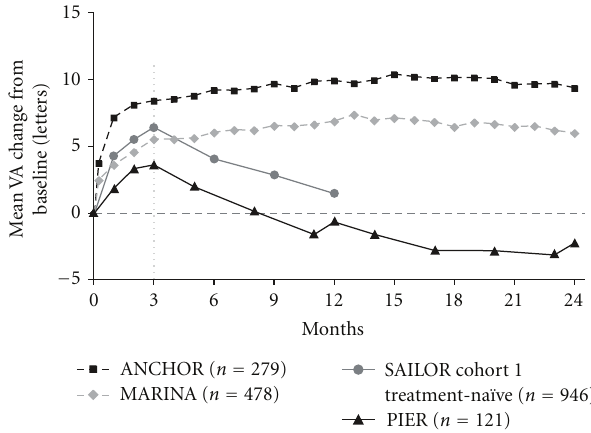
Figure 1: Overall mean change in visual acuity (VA) over time among pooled ranibizumab-treated patients by clinical trial. Dos- ing: ANCHOR and MARINA, monthly; PIER, months 0, 1, 2, 5, 8, 11, 14, 17, 20, and 23; SAILOR, months 0, 1, and 2, then as needed. Vertical line indicates switch from monthly to quarterly and as-needed dosing in PIER and SAILOR,